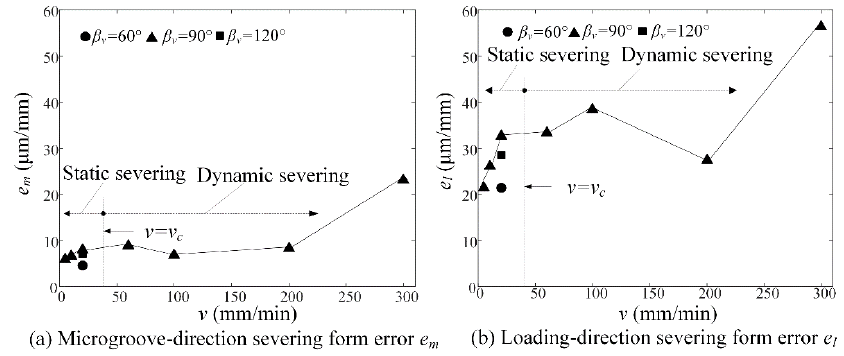
Figure 11. Severing form errors versus loading rate v : ( a ) microgroove-direction severing form error e m and ( b ) loading-direction severing form error e l